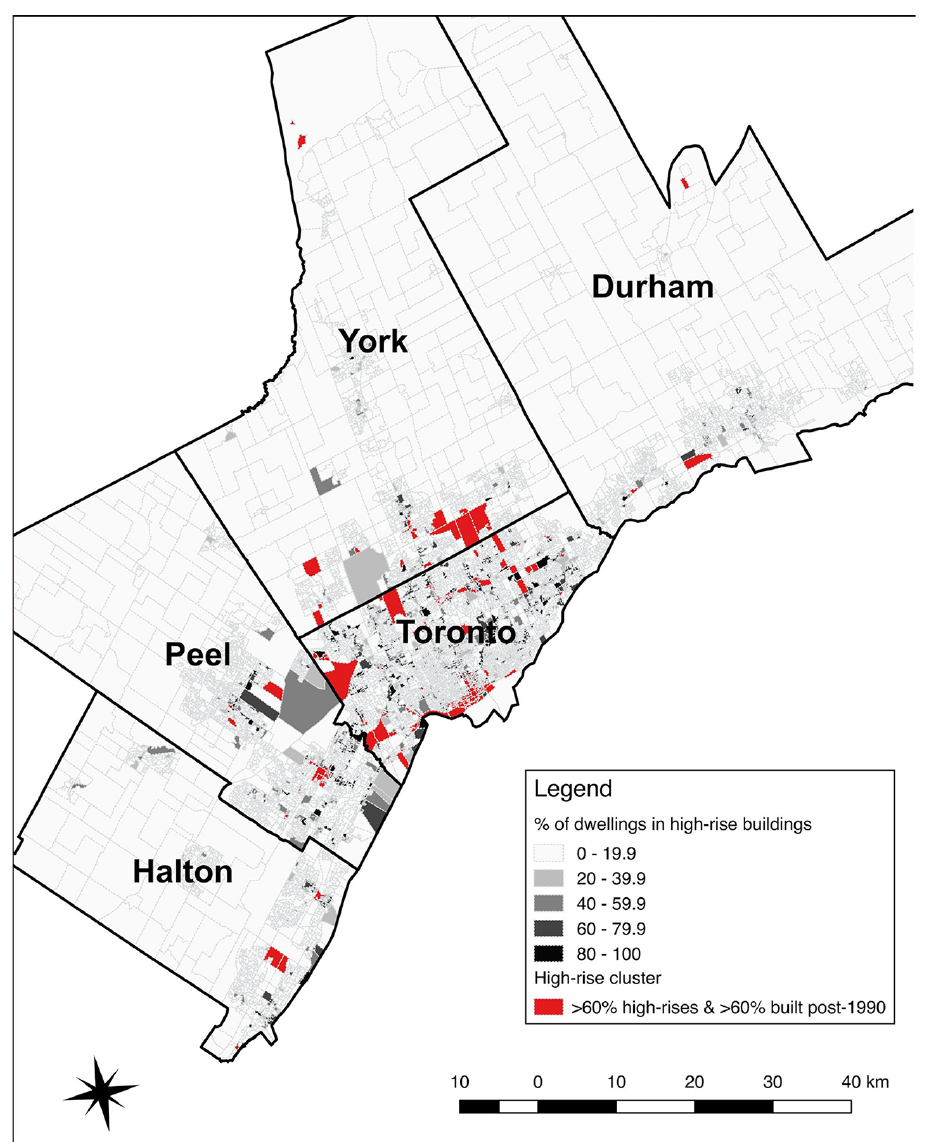
Figure 2. Toronto high-rises. Suburban high-rise clusters are the areas outside of the City of Toronto boundary with 60% to 100% of the housing stock high-rises and >60% constructed after 1990. Source: authors’ calculations using 2016 Statistics Canada DA